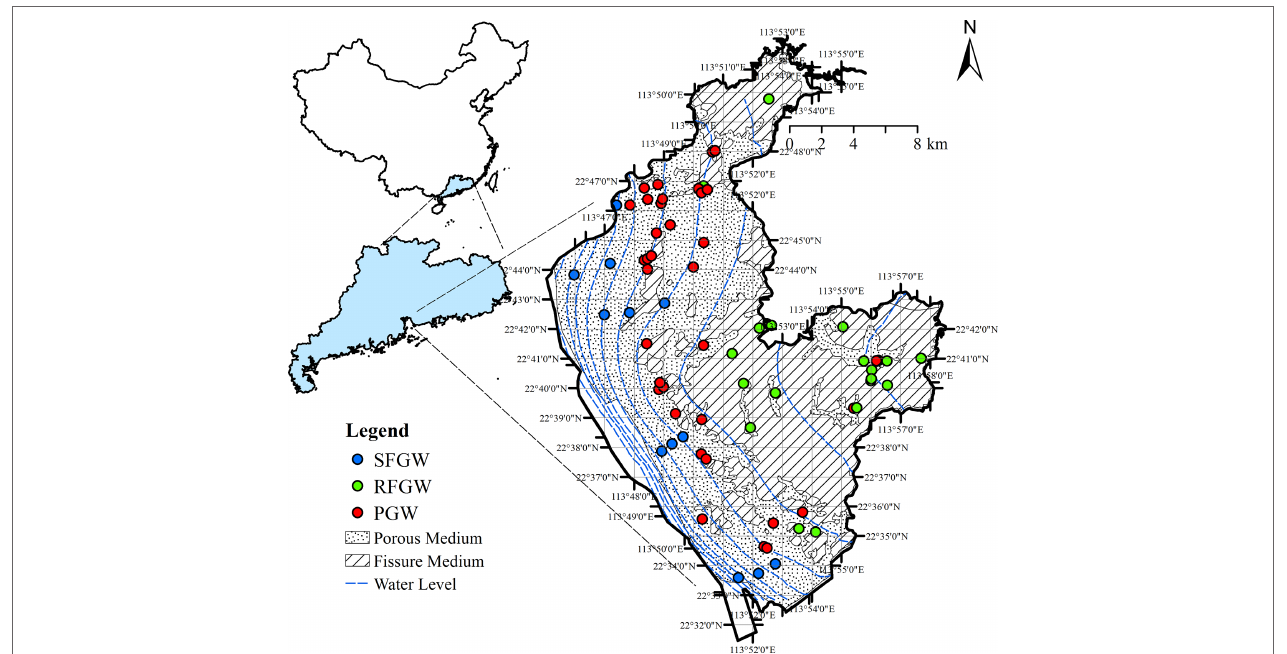
FIGURE 1 | Sampling and geology map and groundwater flow